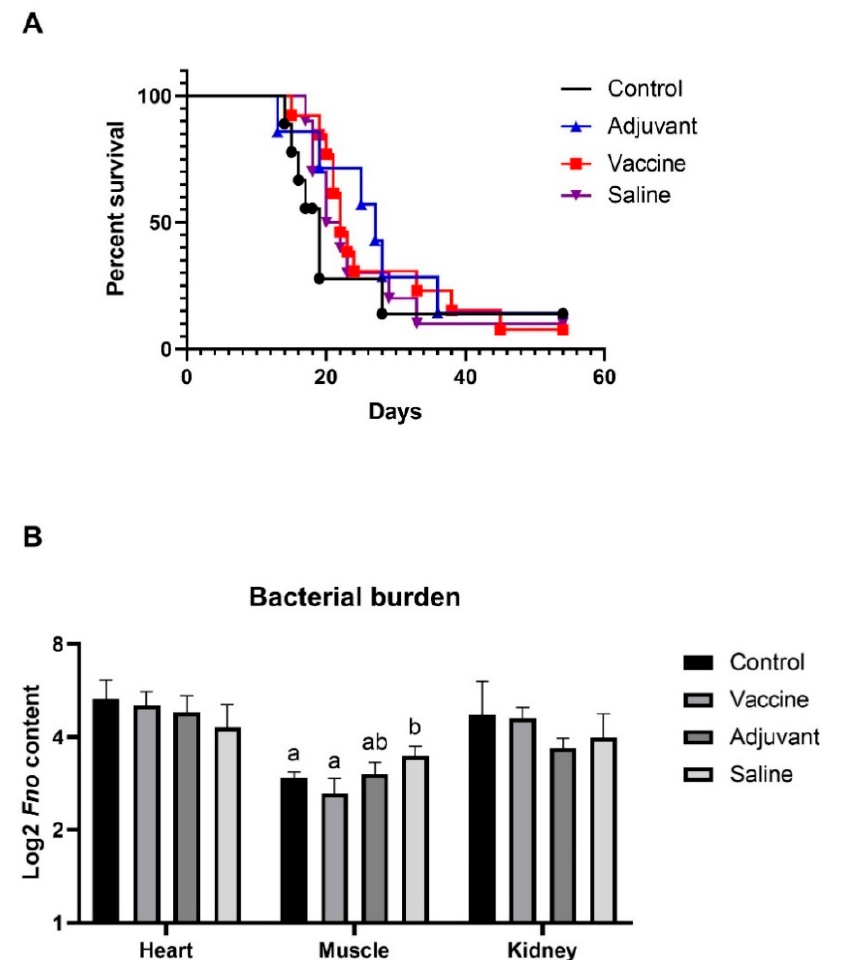
Figure 2. Survival and bacterial burden of adult tilapia immunized with Fo MVs and subsequently challenged with Fo . ( A ) Kaplan–Meier curve of cumulative survival (%) of tilapia immunized with 40 µ g Fo MVs, injected with adjuvant or a saline solution, or left untreated after a cohabitation challenge with shedders injected with 3 × 10 5 CFU/mL of Fo . ( B ) Graphic represents median log 2 of Fo content in heart, muscle and kidney tissues collected during vaccine trial. The bacterial burden was detected by qPCR of genomic DNA isolated from the respective tissues. Different letters (a; b) indicate significant differences; groups that do not share letters are significantly different. The absence of letters indicates a lack of significant differences ( p < 0.05; one-way ANOVA with multiple comparisons using Tukey test; error bars indicate mean ± SEM).